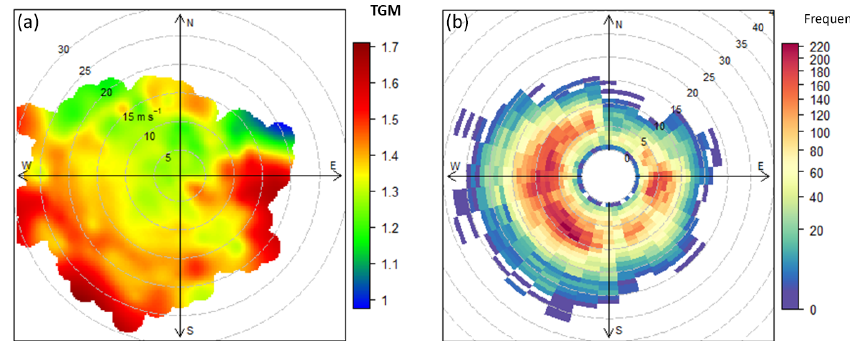
Figure 3. Polar plots for TGM (a) and polar wind frequency (b) at Mace Head. ∗ TGM in ngm − 3 and wind speed in ms − 1 .